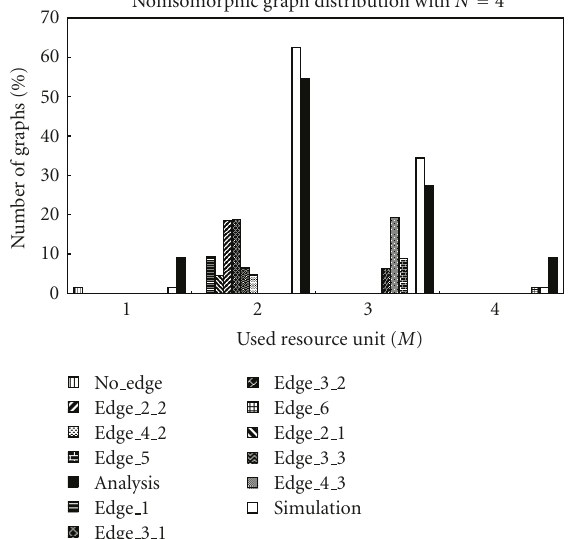
Figure 13: Eleven nonisomorphic graphs for a graph with four